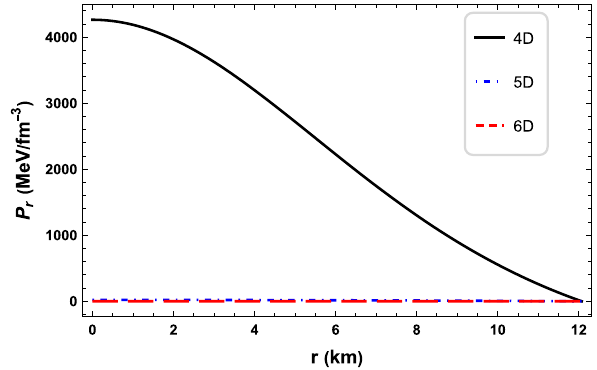
Fig. 5 Comparison of radial variation of radial pressure ( P r ) in PSR J0348+0432 for α = 25 in 4D, 5D and 6D